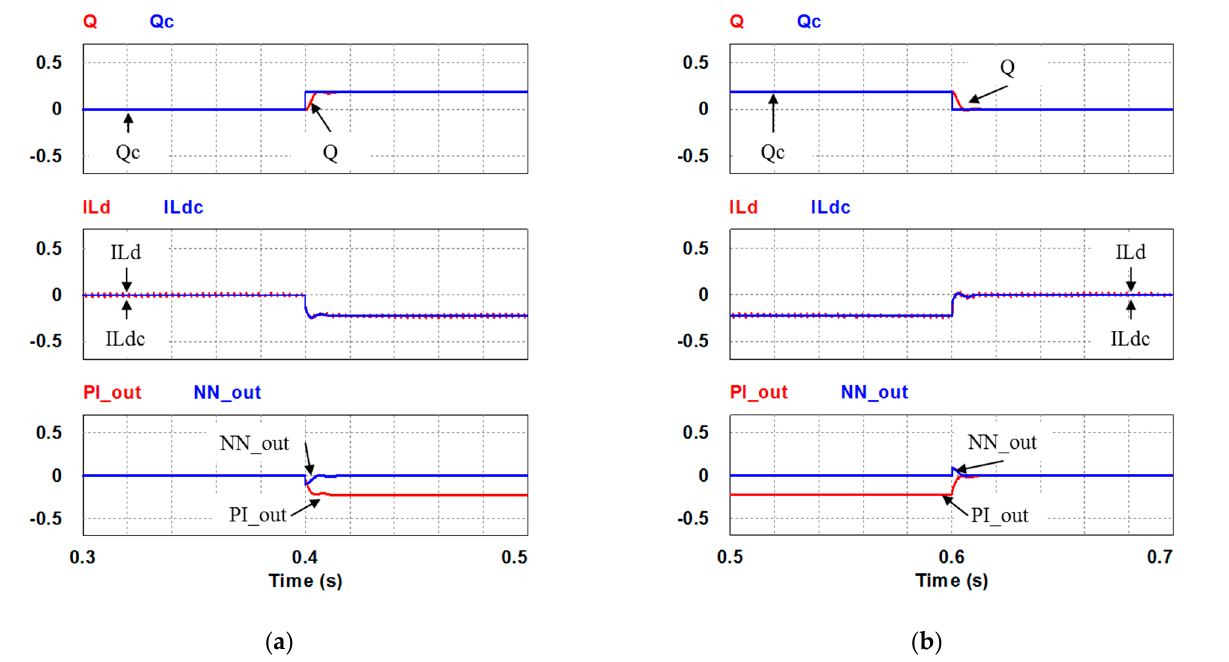
Figure 21. Detailed views of Figure 20a: ( a ) from 0.3 to 0.5 s; ( b ) from 0.5 to 0.7 s.